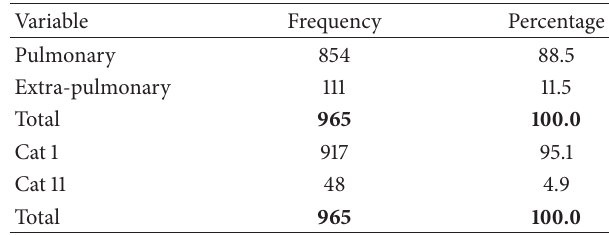
Table 1: Socio-demographic status of respondents. Table 2: Distribution of patients in relation to site of disease and treatment category.